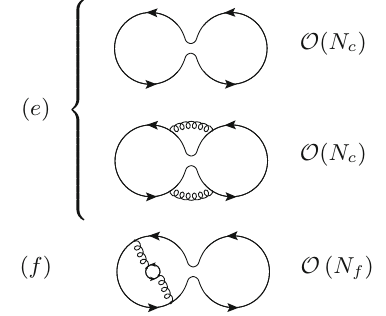
Fig. 3 N c , N f scalingofvariouscontributionstothecolour-connected contraction, corresponding to the O sduu ( x ) insertion